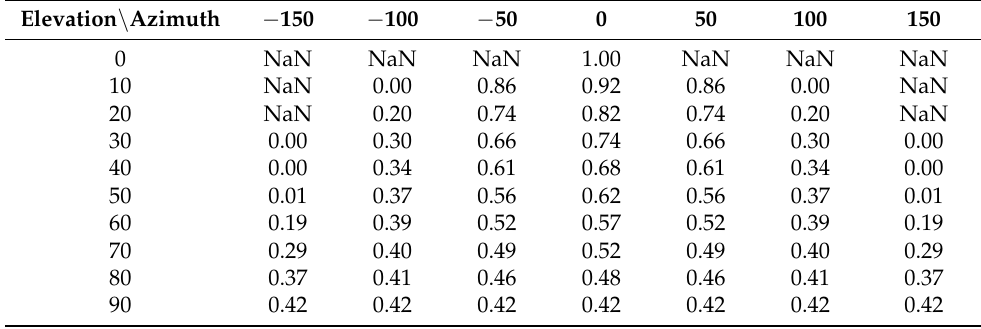
Table 1. Simplified version of the shading table for an arbitrary